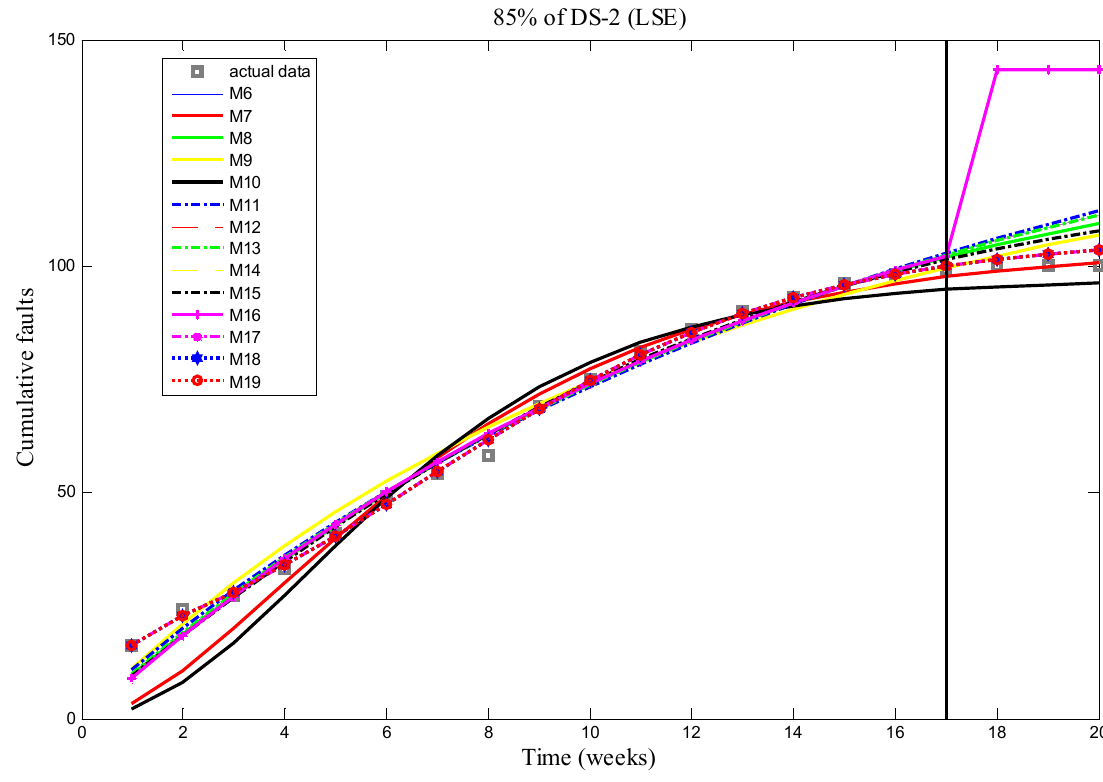
Figure 5. Comparisons of the prediction results for M11-M19 based on DS-2.